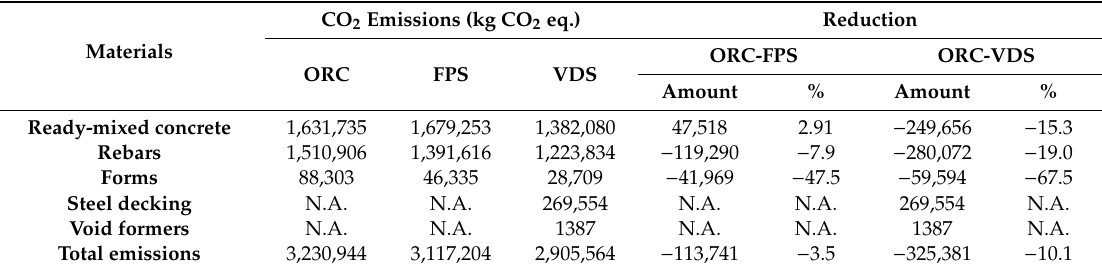
Table 8. Total carbon dioxide emissions and reduction of building